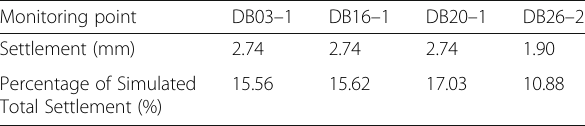
Table 6 Simulated settlement at the first step and the percentage of simulated total settlement